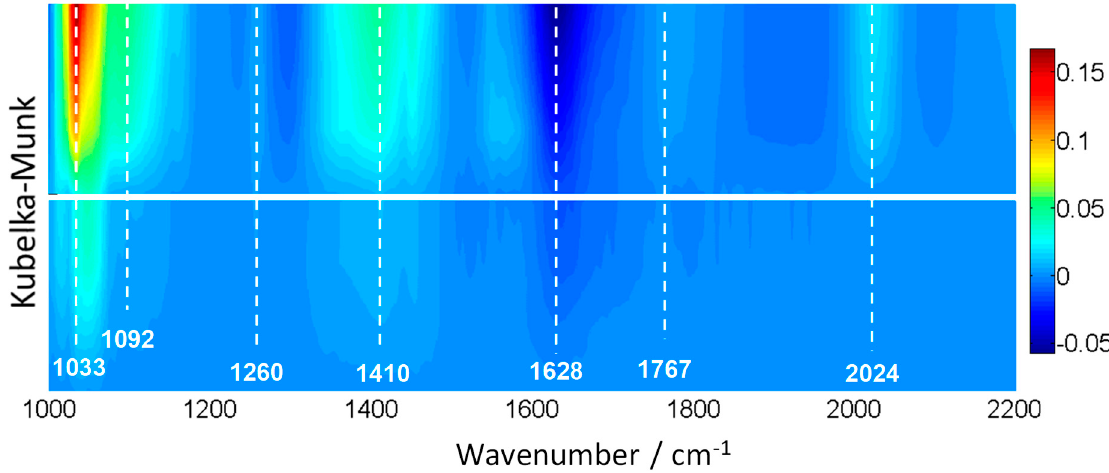
Figure 5. Difference infrared spectra of the T sample using a 70/30 methanol/water reaction mixture under dark ( bottom panel ) and illumination ( upper panel ).